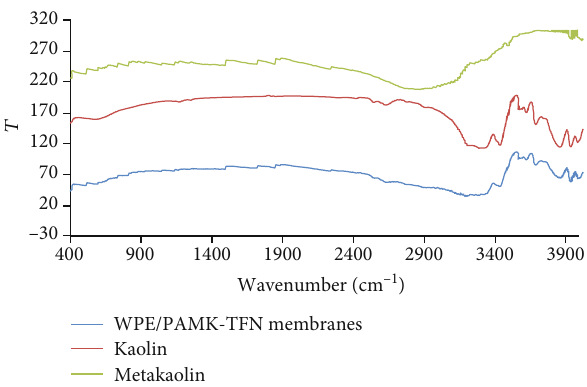
Figure 4: FTIR spectra of kaolin, metakaolin, and WPE/PAMK- TFN membranes.